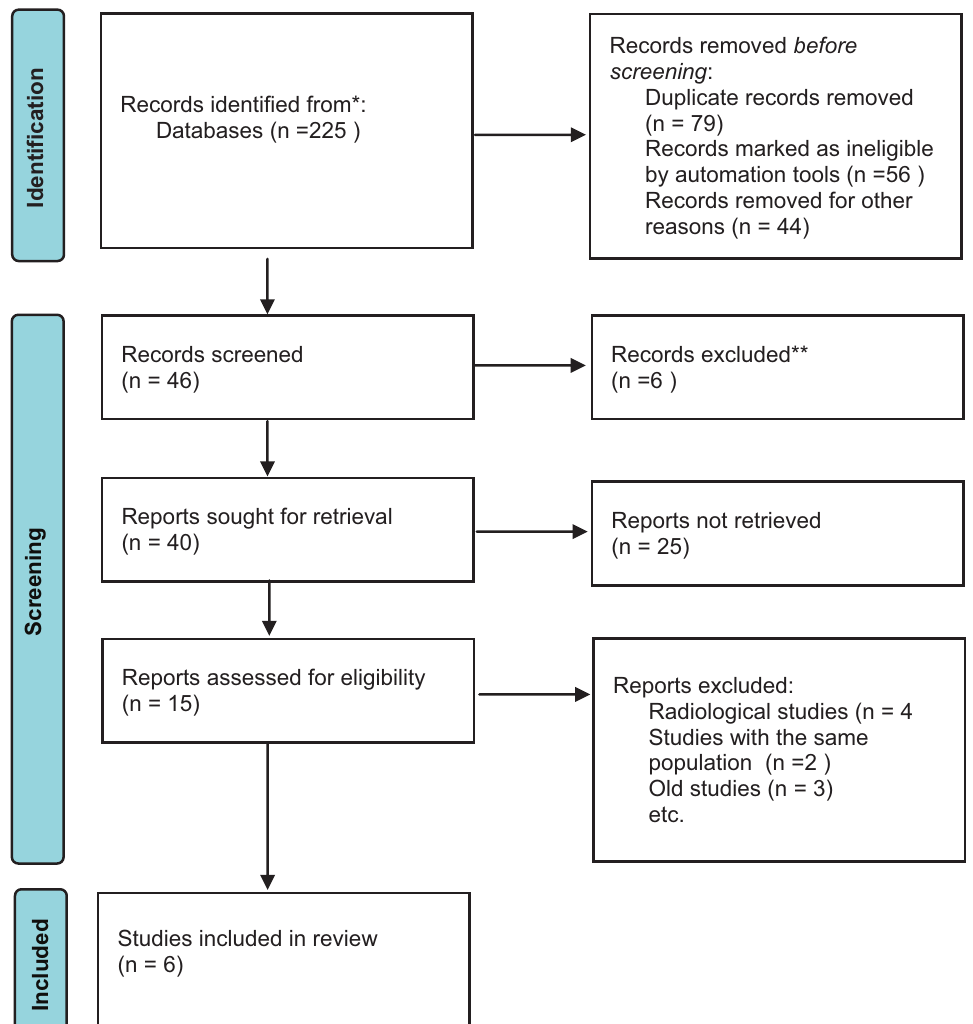
Figure 1. Preferred reporting items for systematic reviews and meta-analyses (PRISMA) fl ow chart.